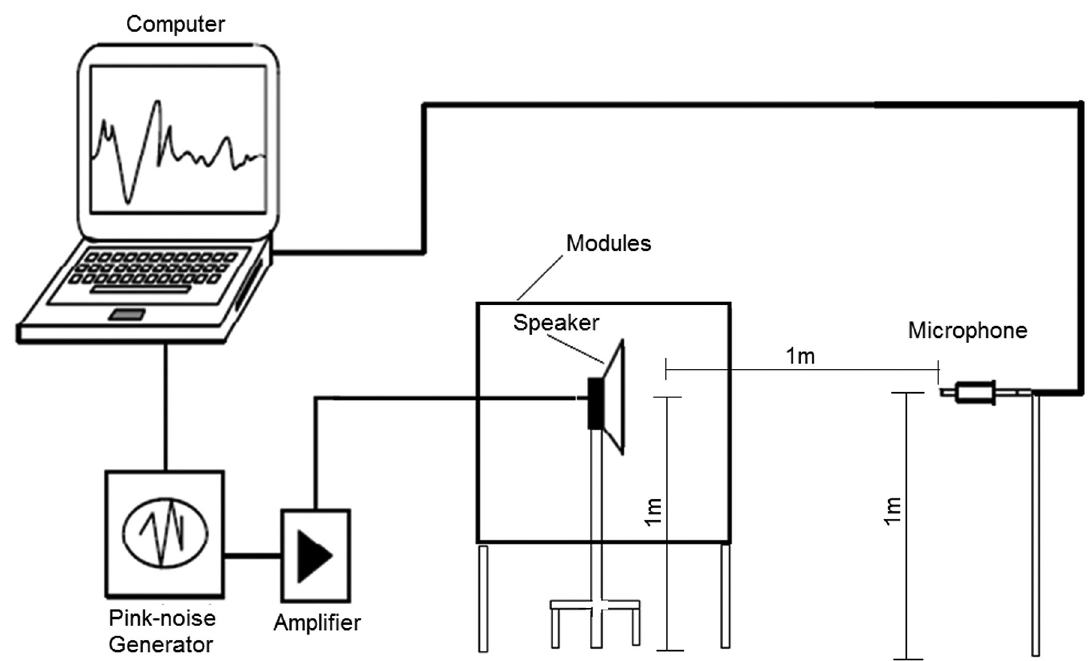
Figure 3. Schematic display of the